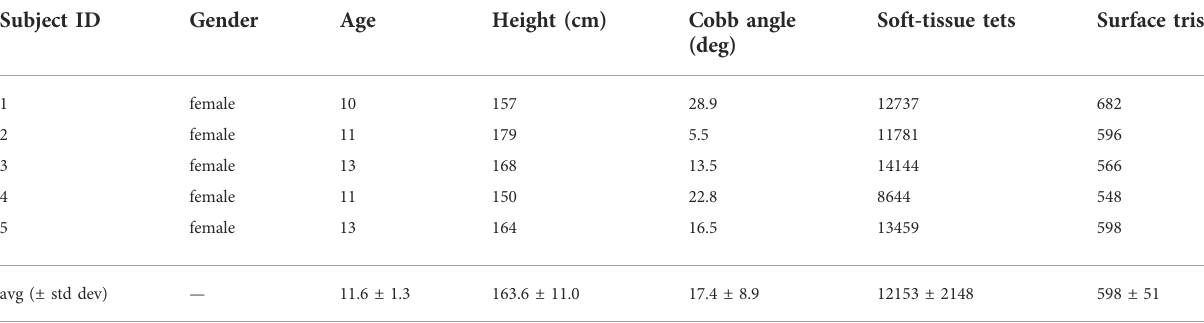
TABLE 1 Features of the subjectsevaluatedin our study. The table indicatesthe severity of the main spine curve (i.e.,the Cobb angle) of each subject, as well as the size of the simulation meshes used in our optimization